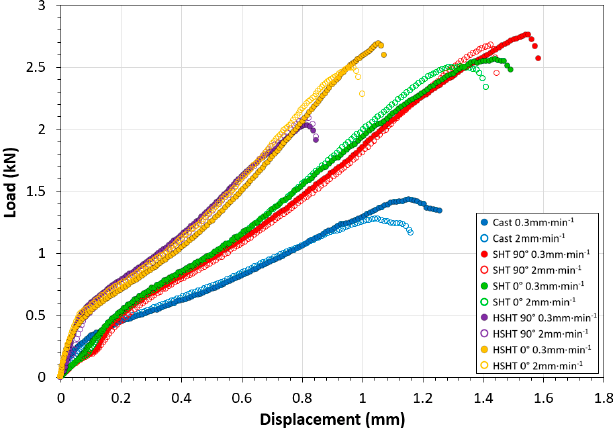
Figure 3. Collation of SPT load-displacement data for all material variants and displacement rates at RT.